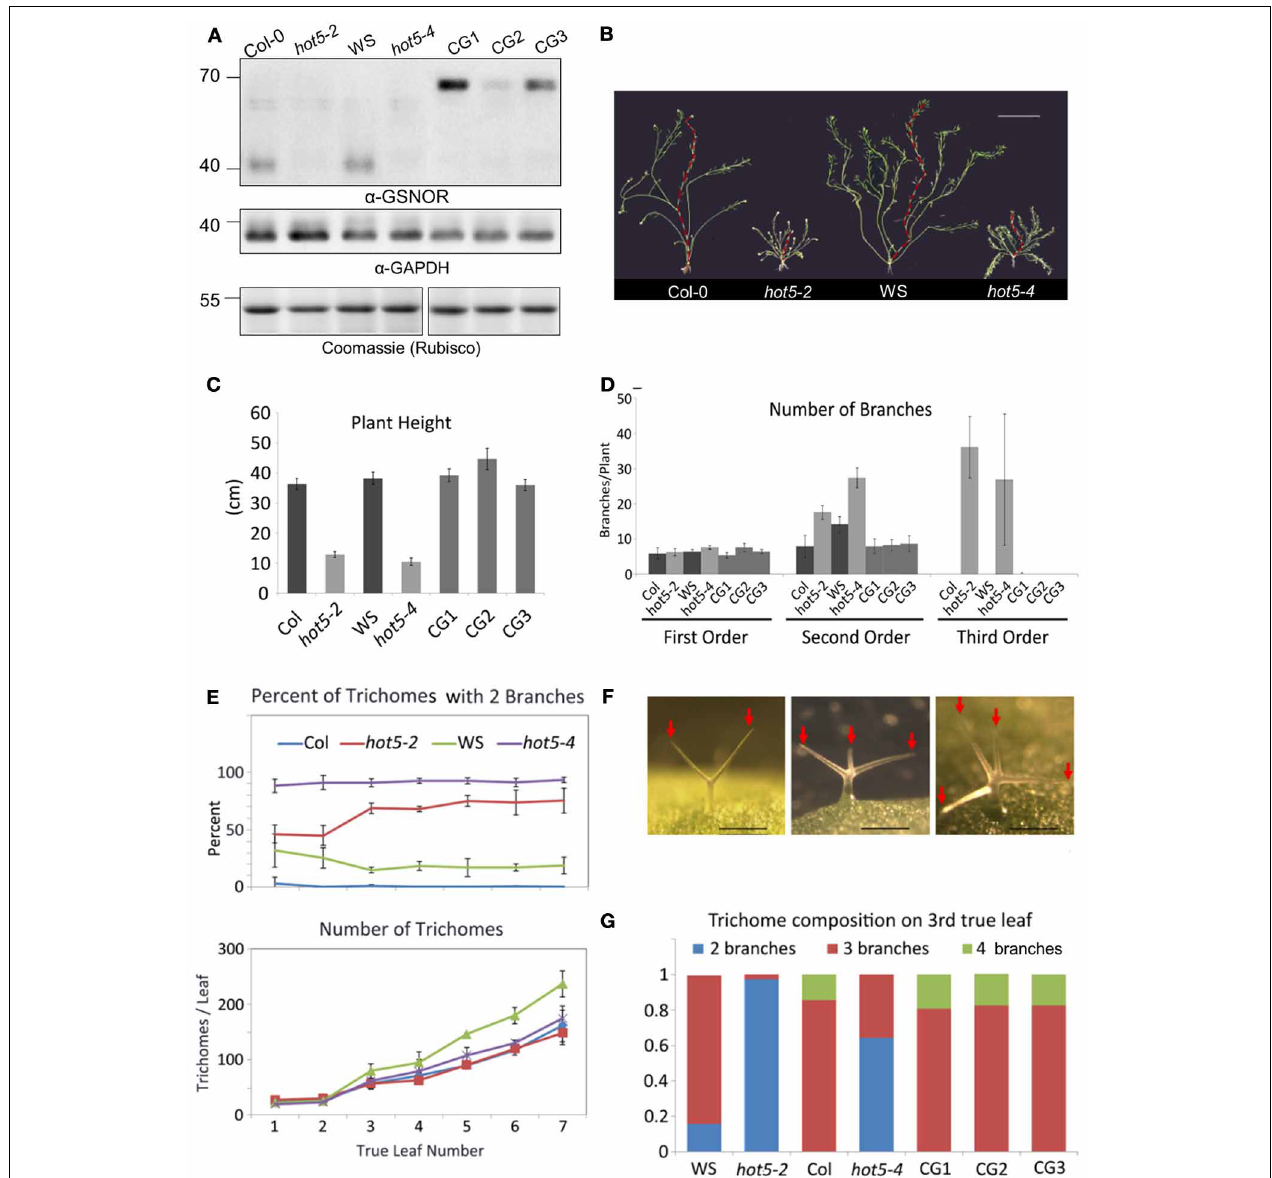
FIGURE 3 | Expression of GSNOR-GFP under its own promoter rescues multiple aspects of the hot5-2 null phenotype. (A) Immunoblots of leaf protein extracts probed with anti-Arabidopsis GSNOR antibodies (top) or anti-cytosolic GAPDH blots (middle). Rubisco large subunit (Coomassie stain, bottom). Plant genotypes are as indicated with CG1, 2, and 3 being independent homozygous T3 lines expressing GSNOR::GSNOR-GFP in the hot5-2 background. (B) Shoot systems of indicated genetic backgrounds